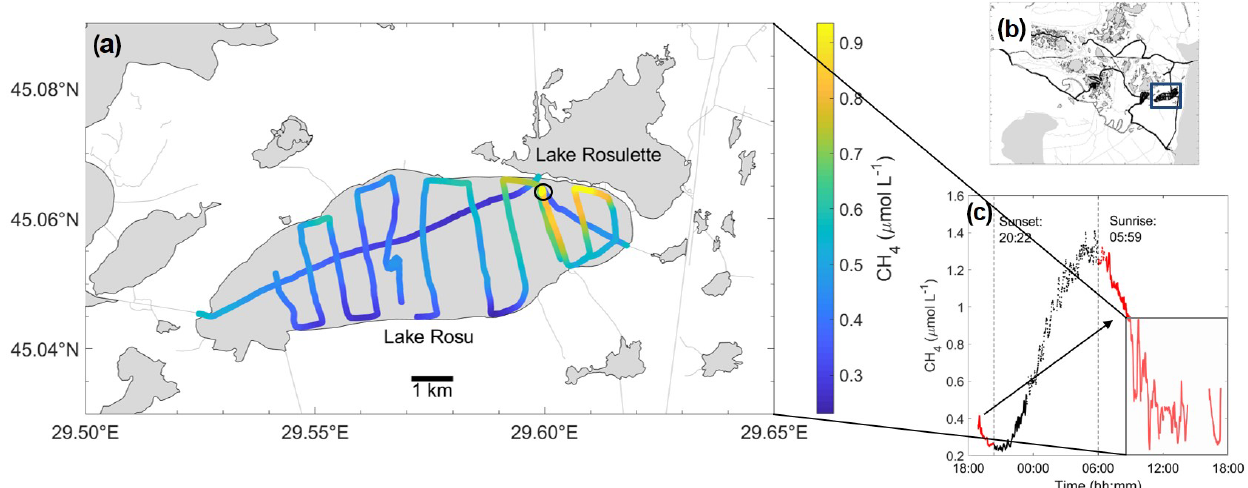
Figure 8. Mapping transect of Lake Ro¸su (a) , with the stationary location ( a circle), map of the entire Danube Delta with Lake Ro¸su ( b blue square) and CH 4 concentration over time to show the distribution over the entire diel cycle ( c ; black shows between sunset and sunrise, red is daytime data, and the box shows the mapping transect). The data shown in panel (c) were used to calculate daylight data (red) and the full daily cycle (all data in c ). Location of diel cycle during the night is shown by the black circle in panel (a) .